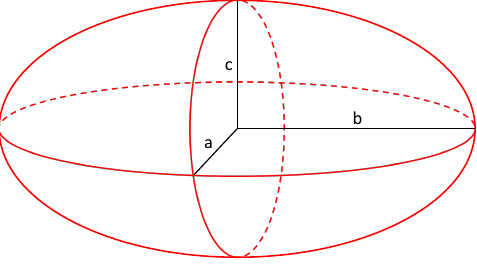
Figure 4. Schematic figure of an ellipsoid with the different radii a , b and c . For modeling the microstructures it was assumed that a = b .